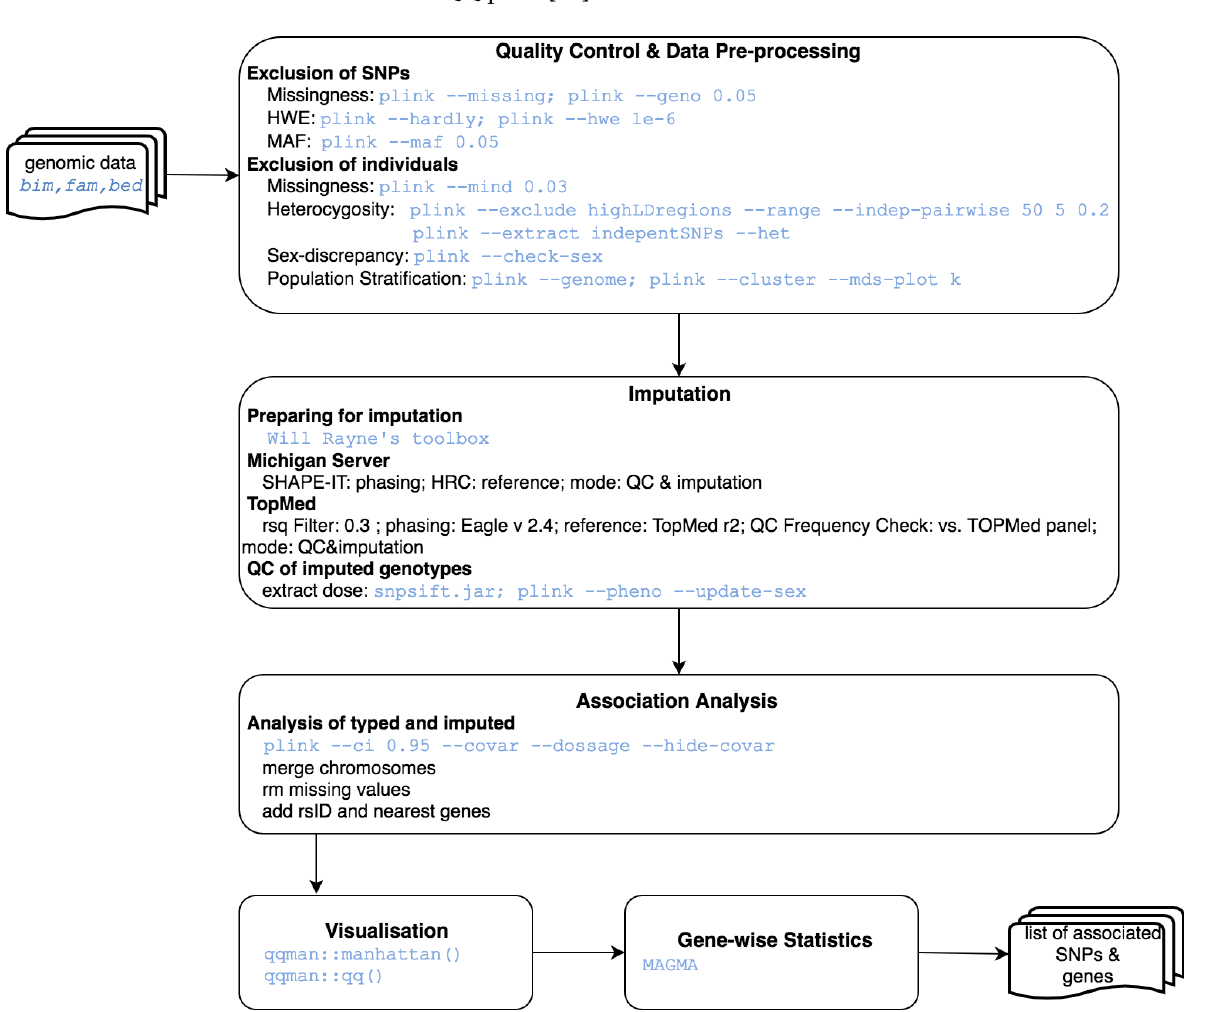
Figure 4. GWAS analysis